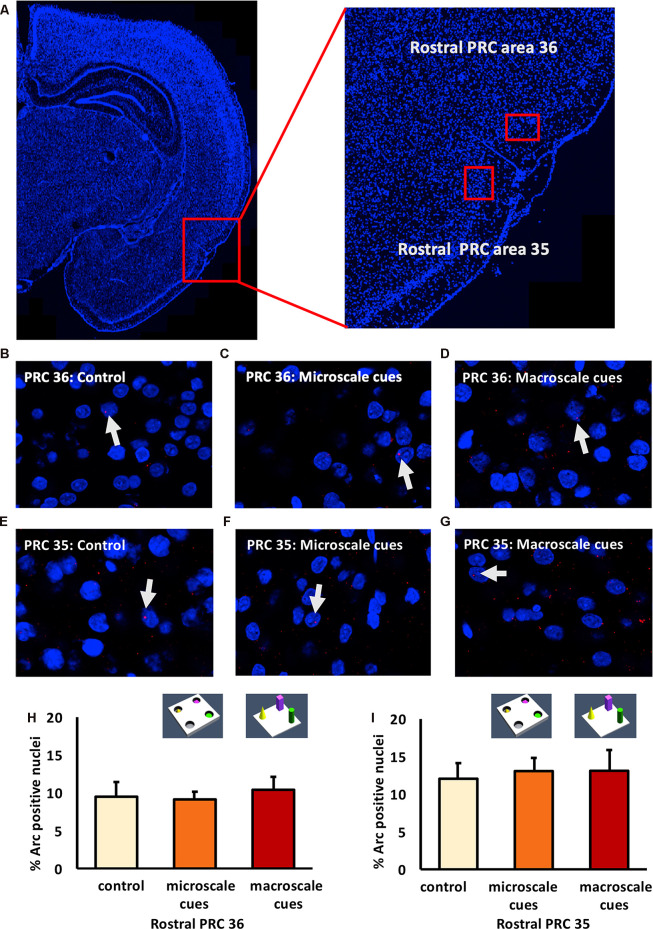
Exploration of item-place configurations does not trigger immediate early gene (IEG) expression in the rostral part of the perirhinal cortex (PRC). (A) Illustration of the rostral part of the PRC (outlined by a red square) in a DAPI-stained coronal section (ca. −3.24 mm posterior to Bregma) of the rat brain (left) and enlargement of the outlined area to show the rostral PRC (right) in which outlines of area 36 (top) and 35 (bottom) are included (indicated by red rectangles). (B–G) Representative images of Arc mRNA expression (red dots, indicated by white arrows) in rostral PRC area 36 (B–D) and area 35 (E–G) after novel exploration of microscale (C,F), or macroscale (D,G) item-place configurations, compared to controls (B,E). Images were taken using a 63× objective. Nuclei were stained with DAPI (blue). (H,I) Bar charts show the relative percentage of Arc-positive nuclei in the rostral PRC area 36 (H) and area 35 (I) following item-place exploration, compared to controls (mean ± SEM). Nuclear Arc mRNA expression in rostral PRC area 36 and area 35 remained unchanged after novel item-place exploration compared to control animals (ANOVA; area 36: F(2,20) = 0.0756, p = 0.927454; area 35: F(2,19) = 0.13803, p = 0.871941).